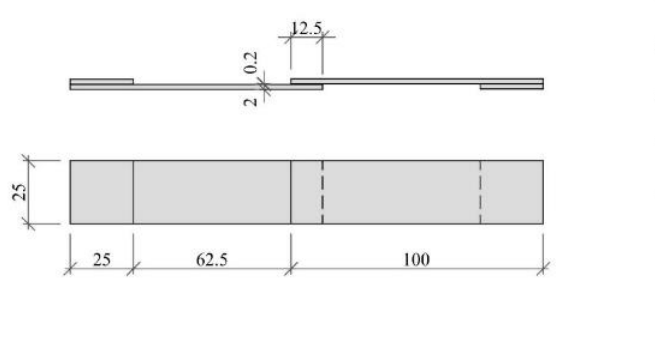
( b ) Figure 4. TAST test: ( a ) the geometry of tested specimen; ( b ) the stress-strain relationship (indirectly determined). The line colors were assigned to the next five identical samples The result, shown in Figure 4b, allows separation of two phases of the adhesive work: elastic and plastic. The shear strength was calculated as the product of the tensile force and the area of the adhesive joint. The elastic limit is noted for an average shear stress of 13.49 MPa and 4.5% average strain (with COV amounted to 4.5% and 6.1%, respectively).